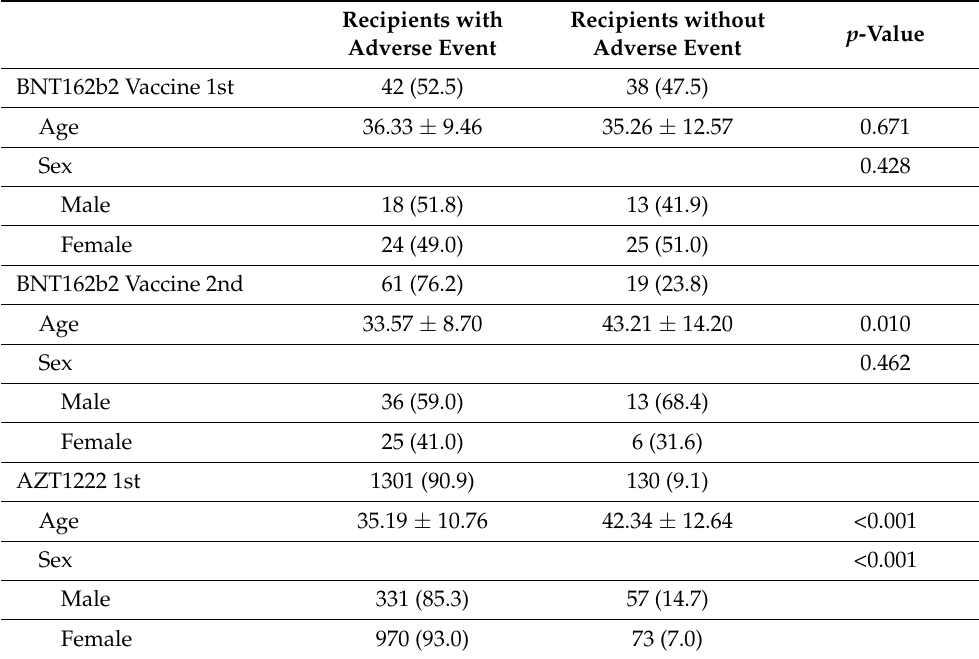
Table 2. Clinical characteristics of vaccine recipients with adverse